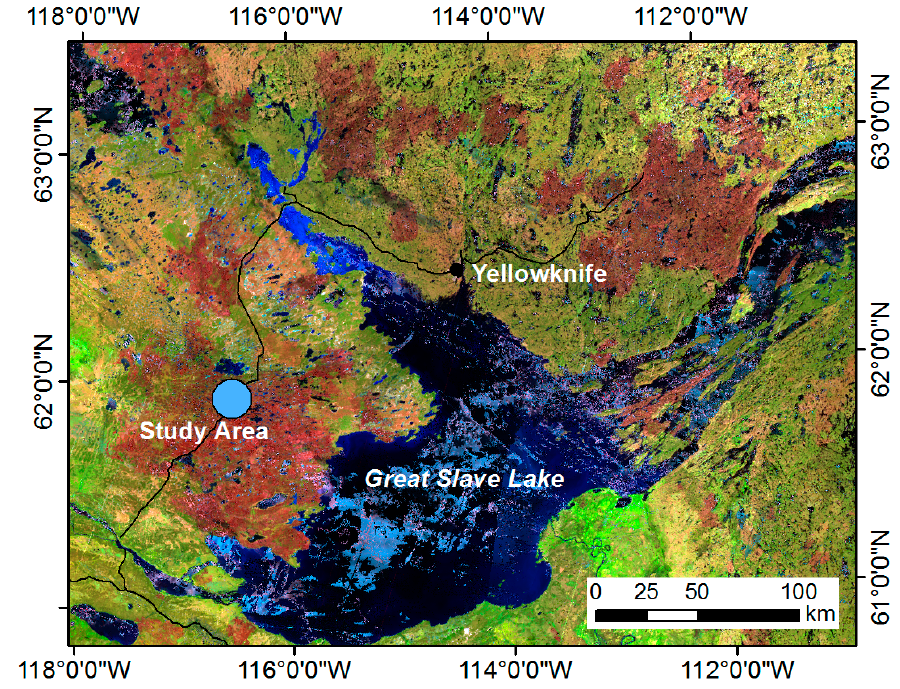
Figure 1. Location of study area in Northwest Territories (blue circle) showing the extent of regional burning in 2014 (dark red patches), visible in a Proba-V satellite image composite from September 2014.